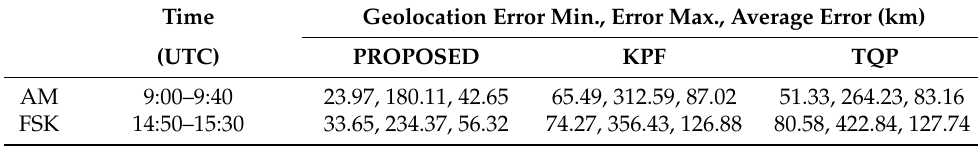
Table 6. Geolocation errors of different methods in experiments. Time Geolocation Error Min., Error Max., Average Error